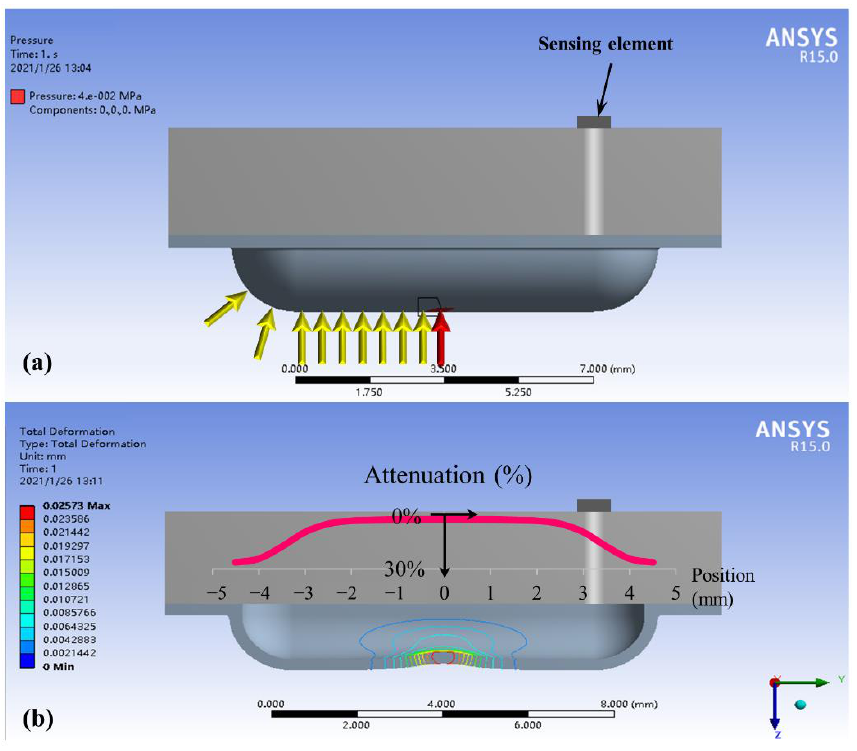
Figure 6. Finite element simulation: ( a ) loading positions; ( b ) results of output pressure and film deformation.